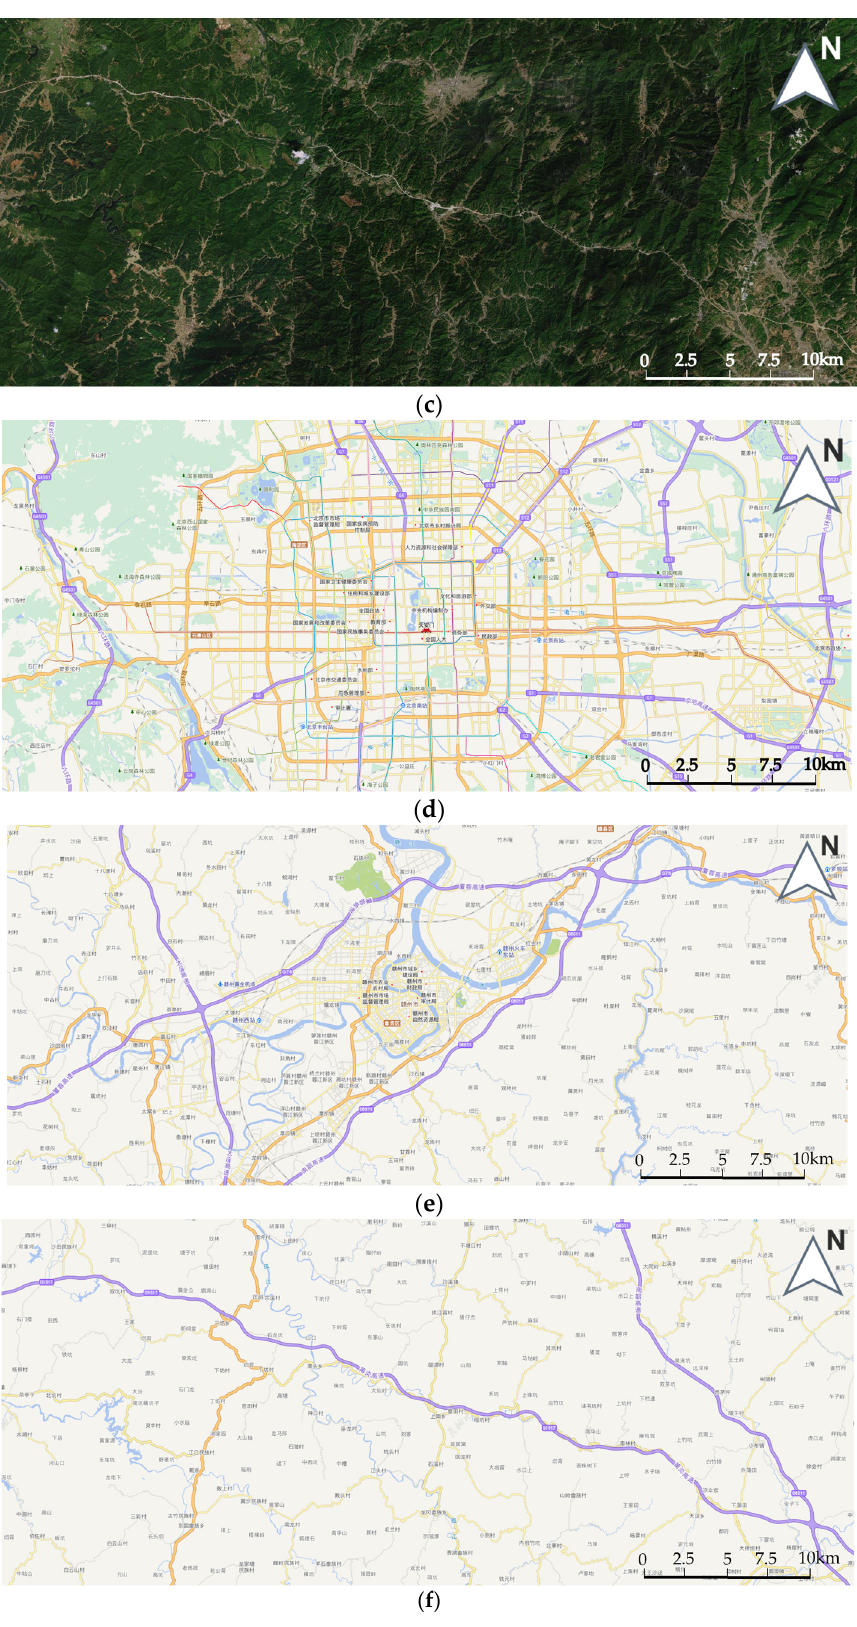
Figure 7. Remote sensing maps and vector maps of Tianditu Beijing, Ganzhou and Shaxi. ( a ) Remote sensing map of Beijing. ( b ) Remote sensing map of Ganzhou. ( c ) Remote sensing map of Shaxi. ( d ) Vector map of Beijing. ( e ) Vector map of Ganzhou. ( f ) Vector map of Shaxi.